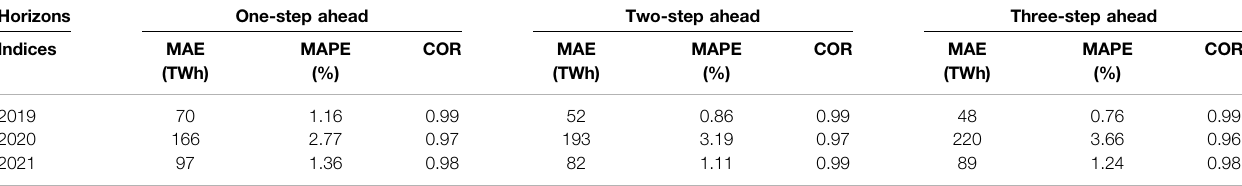
TABLE 3 | Performance evaluation of STL-SARIMA-TCM-RM in 2019, 2020, and 2021. Horizons One-step ahead Two-step ahead Three-step